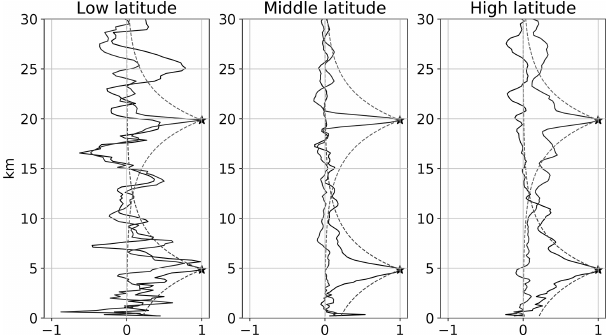
Figure 13. Estimate of RO vertical error correlations at approxi- mately 5 and 20km for low, middle, and high latitudes (full curves). The dashed lines show exponential correlation with three kilometre decay length. No smoothing was applied on any of the data sets before the G3CH was